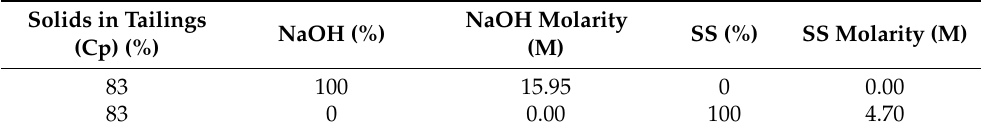
Table 6. Composition of the various geopolymer